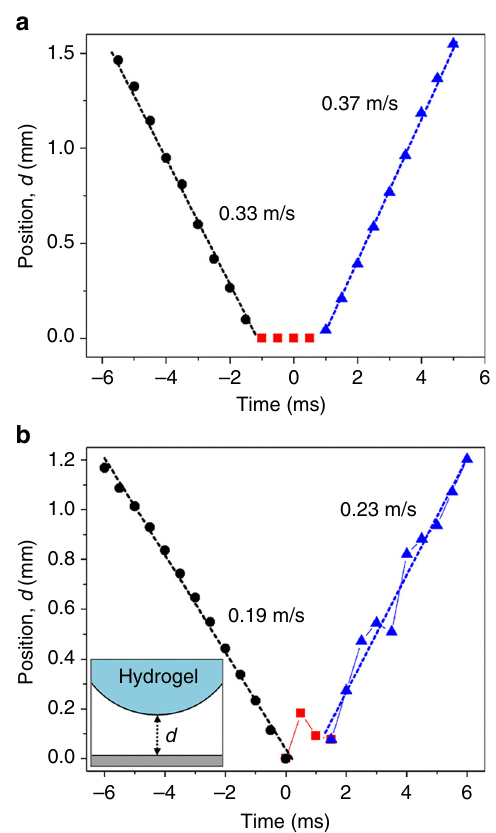
Fig. 5 Incoming and outgoing velocities during impact. a Position of the bottom of a drop from the surface vs. time for a 25 kPa hydrogel drop impacting the surface at ≈ 365 °C. The black circles, red squares and blue triangles indicate incoming, contact, and outgoing portions of the